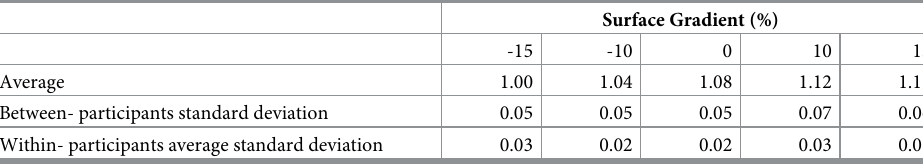
Table 6. Walking (1.25 m/s) cycle time (s) over a range of surface